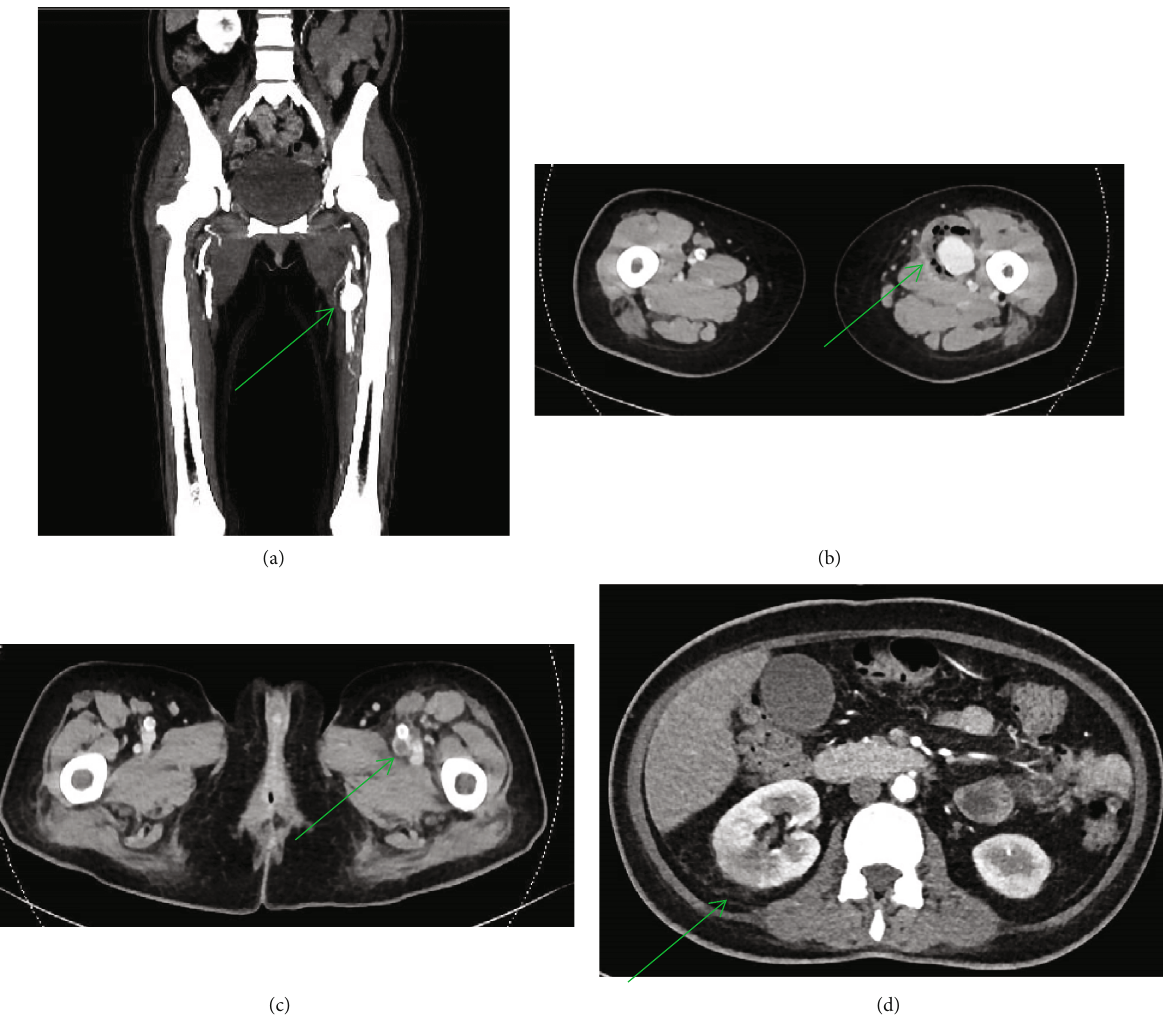
Figure 1: (a) Arrow indicates saccular pseudoaneurysm of super fi cial femoral artery. (b) Arrow indicates gas containing intramuscular fl uid collection surrounding the pseudoaneurysm. (c) Arrow indicates fi lling defect within the common femoral vein. (d) Arrow indicates hypoenhancing area in the right kidney with surrounding fat